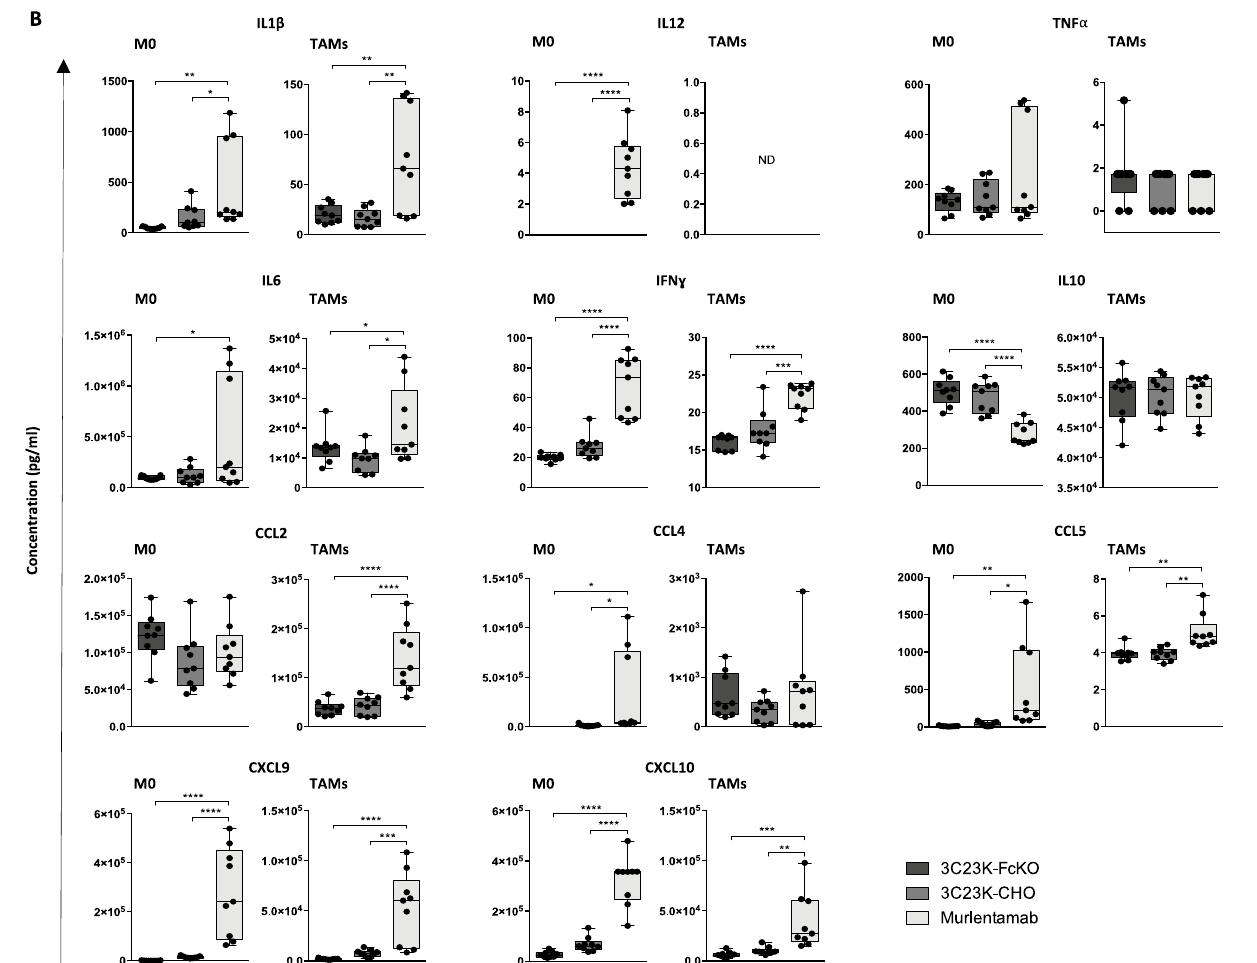
Figure 3. Murlentamab opsonization of SKOV3-R2 + orients naïve macrophages and reprograms TAMs towards an M1-like profile. SKOV3-R2 + ovarian tumor cells were labeled with different 3C23K antibodies (3C23K-FcKO control, 3C23K-CHO normally fucosylated or murlentamab the low fucosylated form) and cultured in the presence of human monocyte-derived macrophages from healthy donors unstimulated (M0) or stimulated with M-CSF and IL-10 (TAMs). ( A ) The proportion of macrophages expressing M1/M2 membrane markers (CD32, CD64, CD80, TLR2, CD163, CD36 and CD206) was determined by flow cytometry after three days of co-culture with SKOV3-R2 + cells. ( B ) The release of cytokines (IL1 β , IL12, TNF α , IL6, IFN γ , IL10) and chemokines (CCL2, CCL4, CCL5, CXCL9 and CXCL10) in the culture medium was determined by AlphaLISA after three days of co-culture with SKOV3-R2 + cells. Data shown (boxplots) are the results from three different experiments (performed with three different healthy donors). * p < 0.05; ** p < 0.01; *** p < 0.001; **** p < 0.0001. p values were determined using one-way ANOVA analysis followed by Tukey’s multiple comparisons